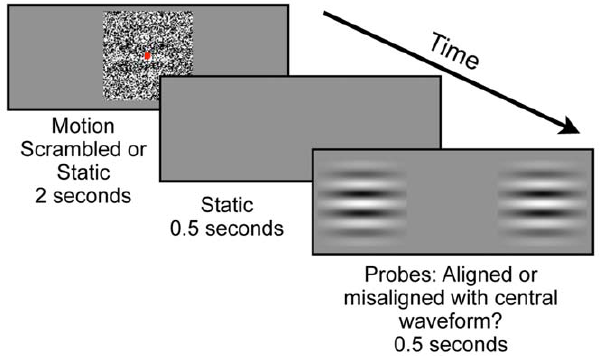
Figure 4. Experiment 3 procedure. A) Depiction of procedure for Experiment 3. Observers viewed two seconds of smooth motion, followed by a blank inter-stimulus-interval (ISI), after which two adjacent probes were presented that contained waveforms either aligned or misaligned with the previously visible central test waveform. Observers indicated if the probe waveforms were aligned or misaligned with the remembered test waveform.